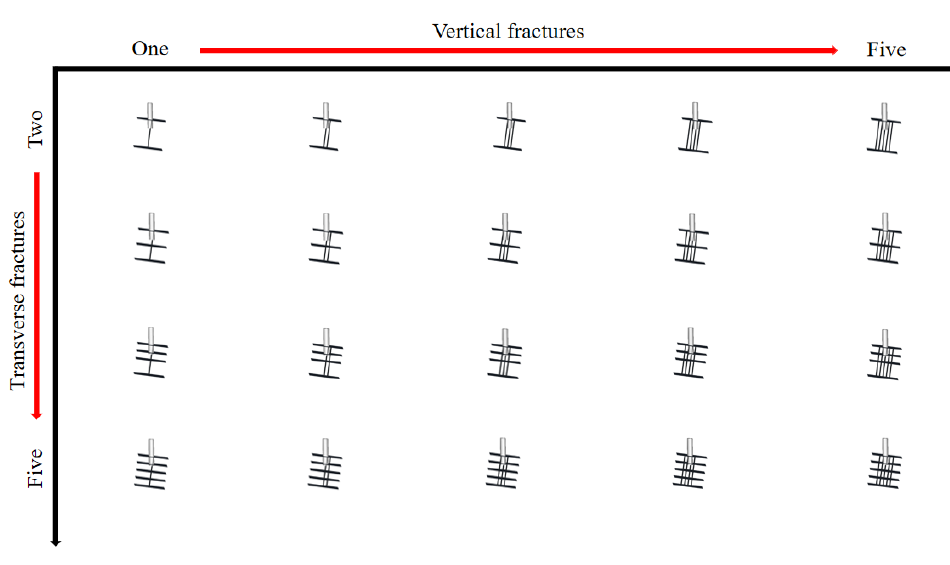
Figure 6. Twenty groups of typical fracture networks.